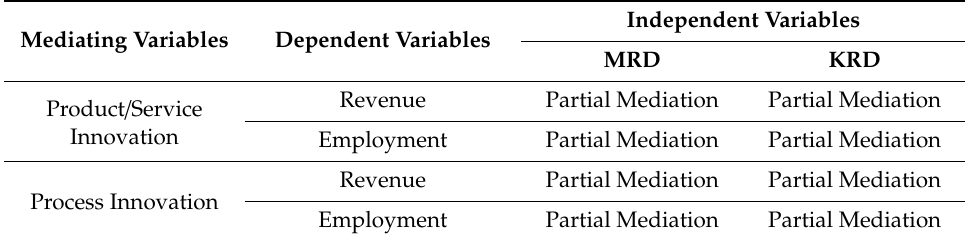
Table 5. Summary of results for mediating e ff ect